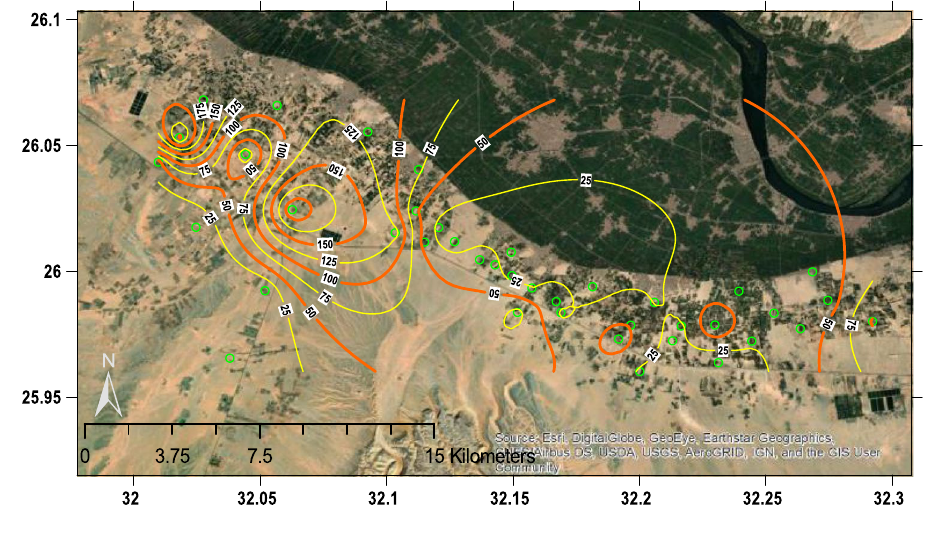
Fig. 12 Nitrate concentrations (in mg/L) contour map of the study